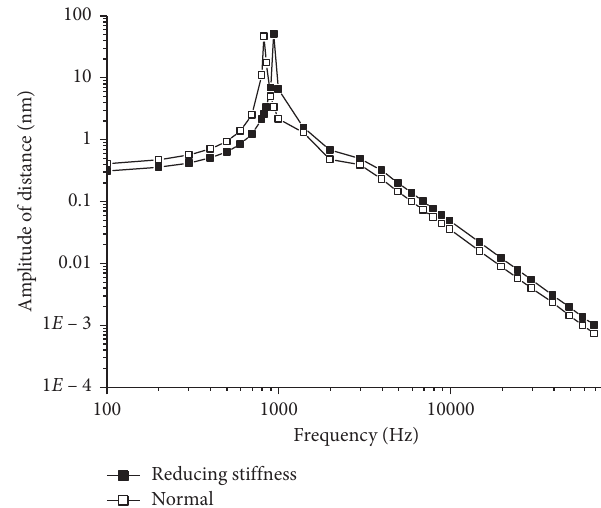
Figure 7: The elastic modulus of OHCs reducing by half.